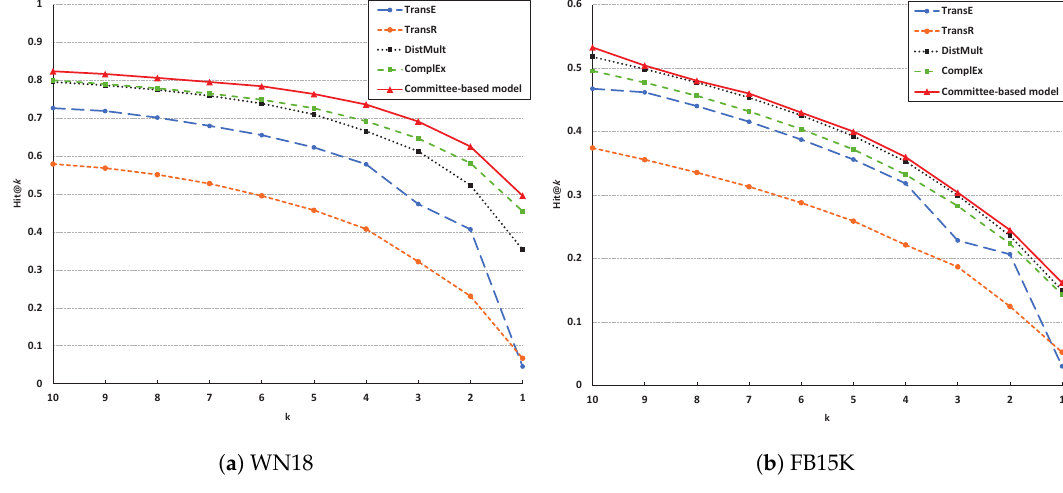
Figure 2. Change of Hits@k as k